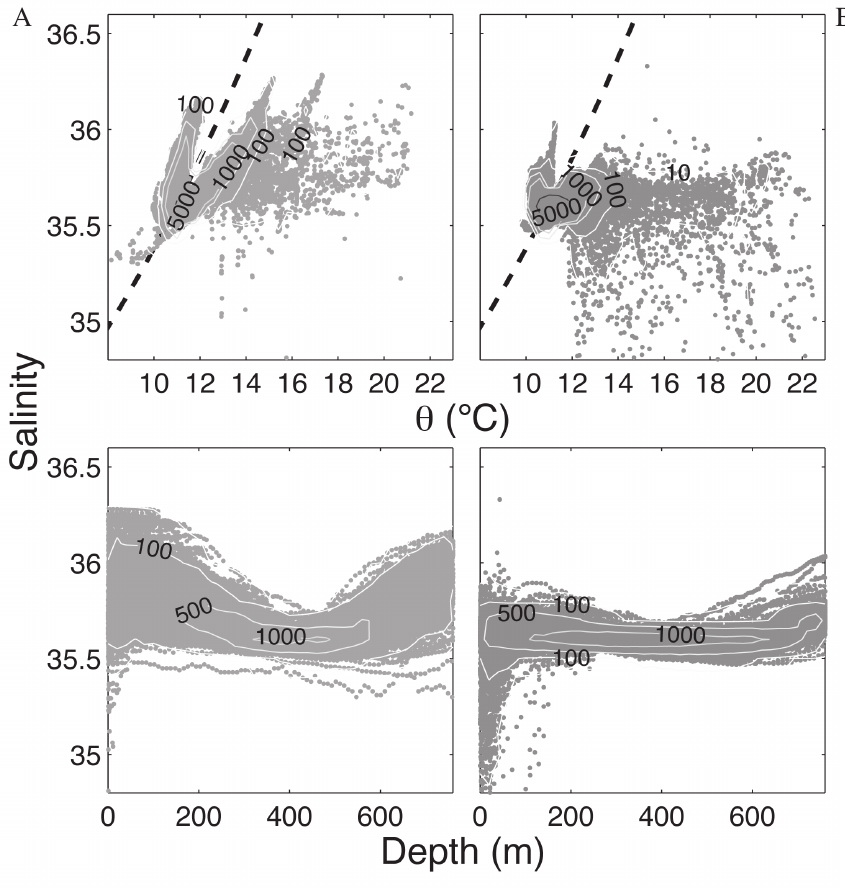
Fig . 3. – S −θ (upper) and S − d (lower) relationships in the Galician Area (A) and Cantabrian Sea (B). σ